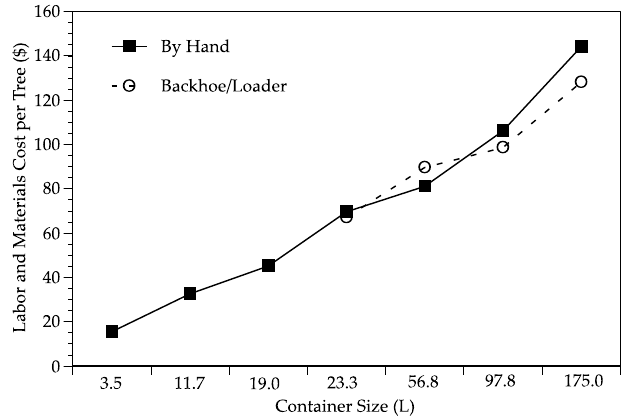
Figure 2. Labor and materials cost [US$] per tree for transplant by hand or machinery of various container size trees in 2013 (excluding wholesale cost of tree) as determined from RSMeans [23].